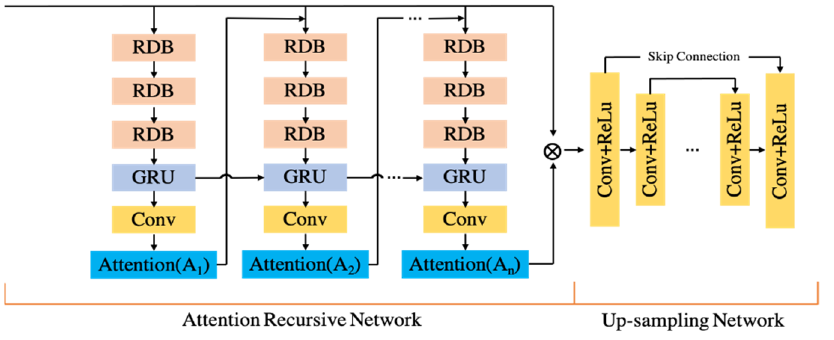
Figure 3. Attention recursive network structure design.